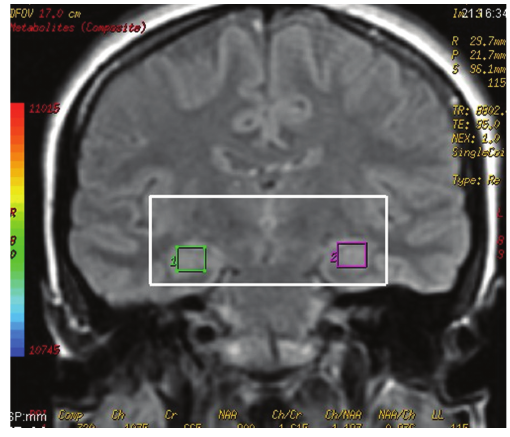
Figure 1: Position of hippocampal voxels and sample magnetic resonance